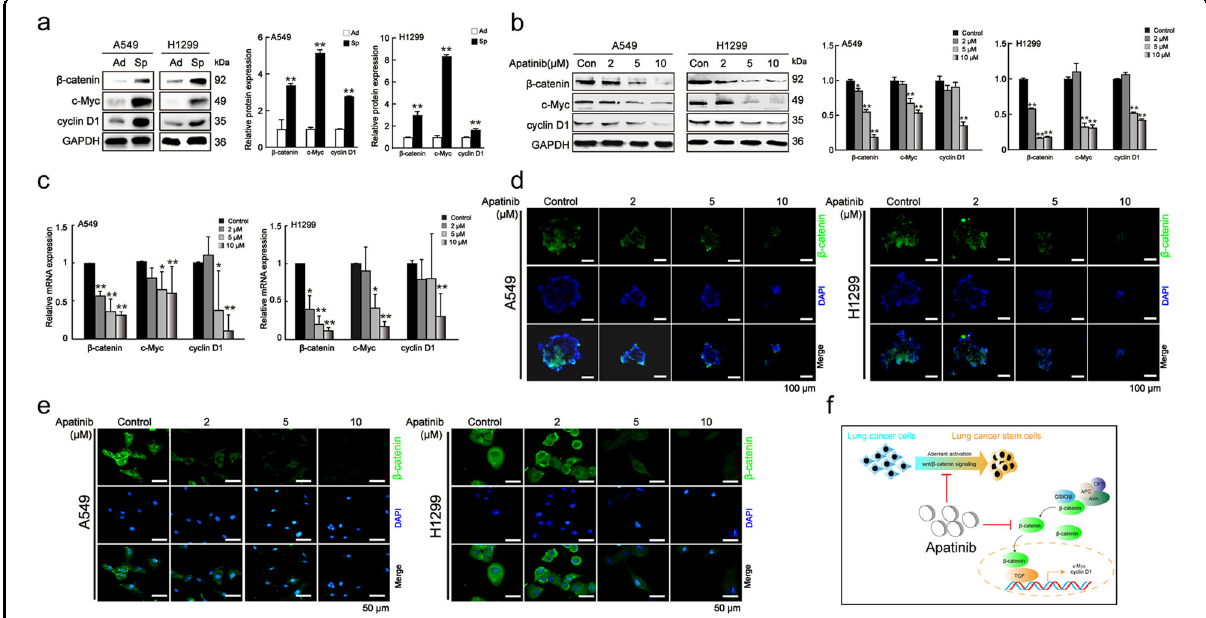
Fig. 3 Apatinib reduced β -catenin expression and downregulated its responsive genes. a Protein levels of β -catenin and downstream genes (c-Myc and cyclin D1) in adherent cells and spheroids. Ad adherent cells, Sp spheroids. Unpaired t -test was used. Data are presented as mean ± SD ( n = 3). ** p < 0.01 compared to the control group. b Protein and mRNA levels of β -catenin and downstream genes in A549 and H1299 spheroids on day 7 after apatinib treatment. One-way ANOVA (Bonferroni ’ s multiple-comparison test) was used. Data are presented as mean ± SD ( n = 3). * p < 0.05, ** p < 0.01 compared to the control group. c mRNA levels of β -catenin and downstream genes in spheroids on day 7 after apatinib treatment. One-way ANOVA (Bonferroni ’ s multiple-comparison test) was used. Data are presented as mean ± SD ( n = 3). * p < 0.05, ** p < 0.01 compared to the control group. d Representative immuno fl uorescence of β -catenin (green) in apatinib-treated spheroids. DAPI: blue. Scale bar = 100 μ m. e Representative immuno fl uorescence images of β -catenin (green) in adherent cells on day 2 after apatinib treatment. DAPI: blue. Scale bar = 50 μ m. f Schematic representation of the effect of apatinib on β -catenin signaling in lung